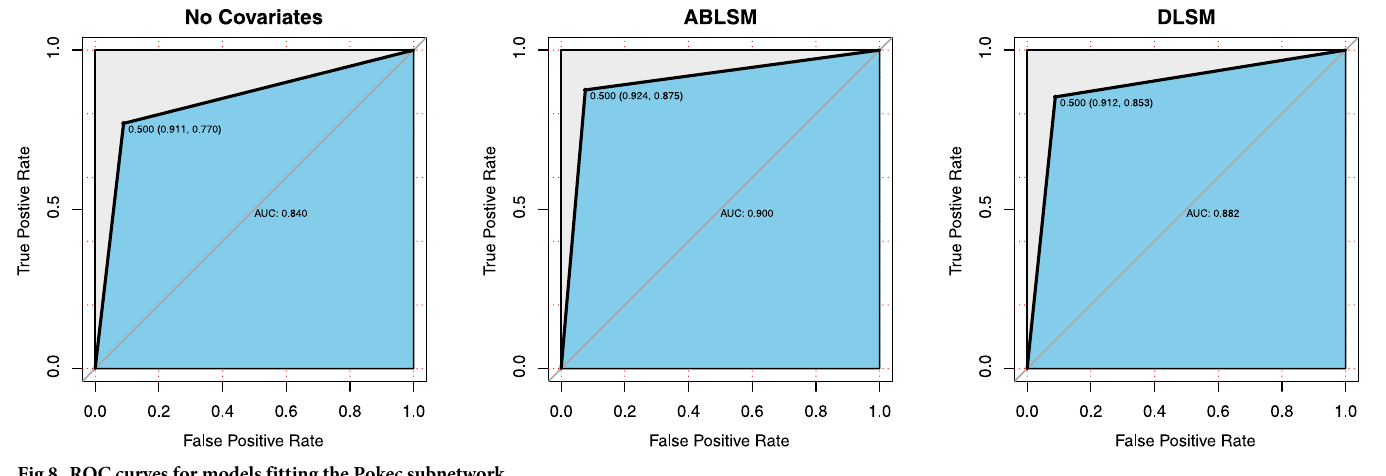
Fig 8. ROC curves for models fitting the Pokec